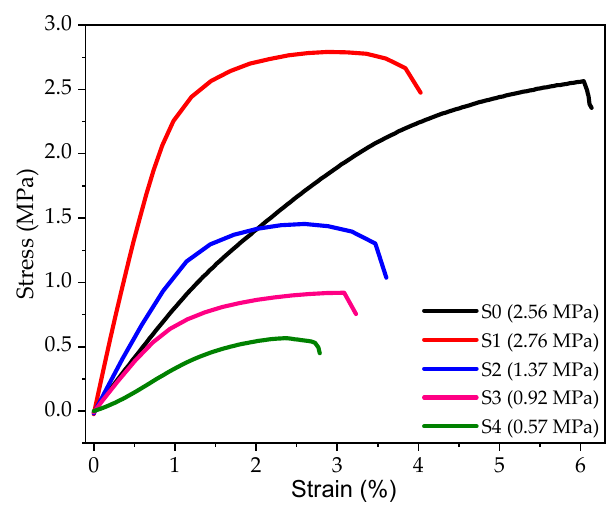
Figure 3. Tensile stress-strain curves of gelatin/ β -CD and gelatin fiber adsorbents.